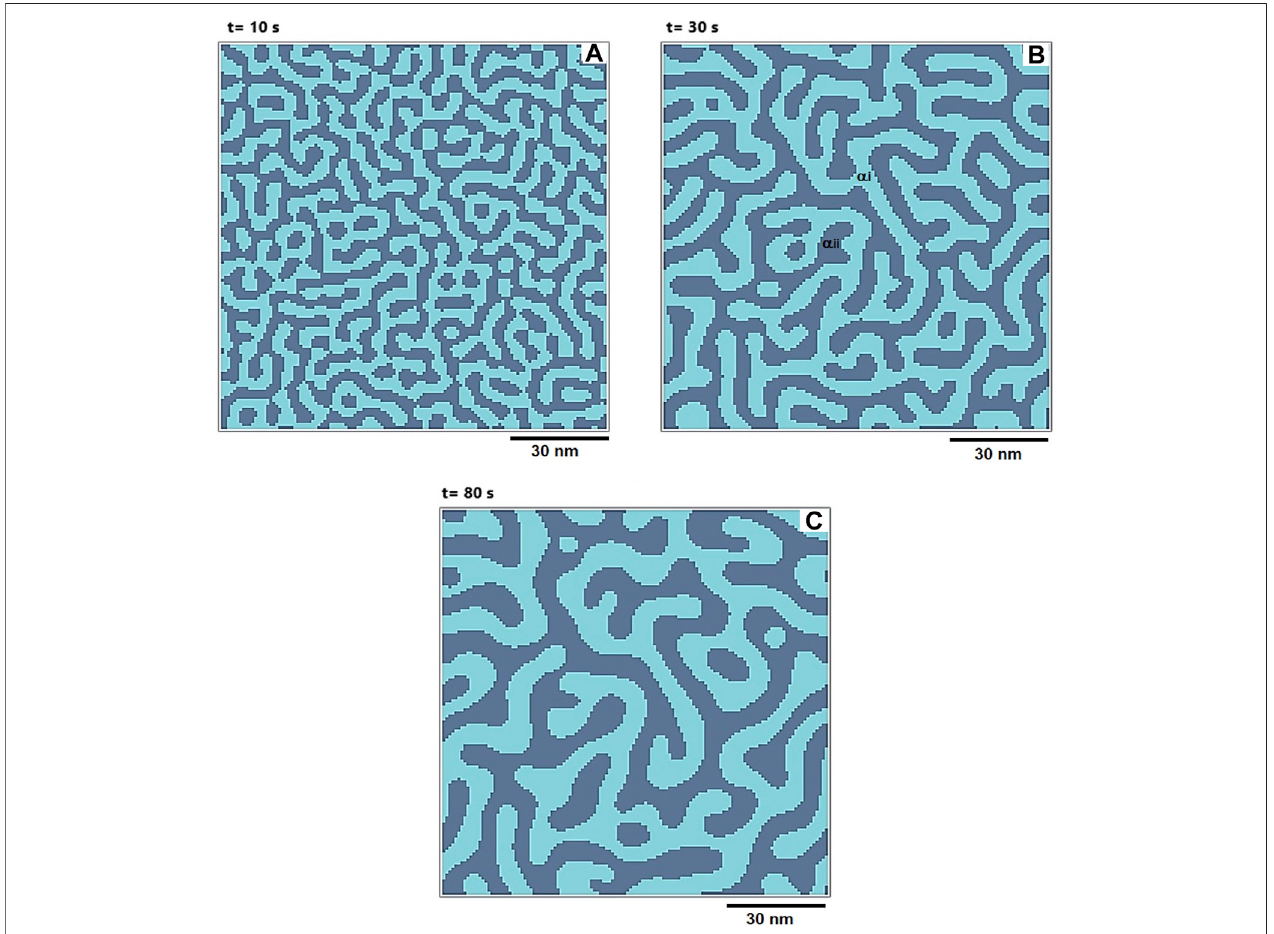
FIGURE 12 | Simulated microstructure of the A – B – C alloy for case IV with X A = 0.40 , X B = 0.40 , and X c = 0.20 aged at 800 K for (A) 10 s, (B) 30 s, and (C) 80 s.